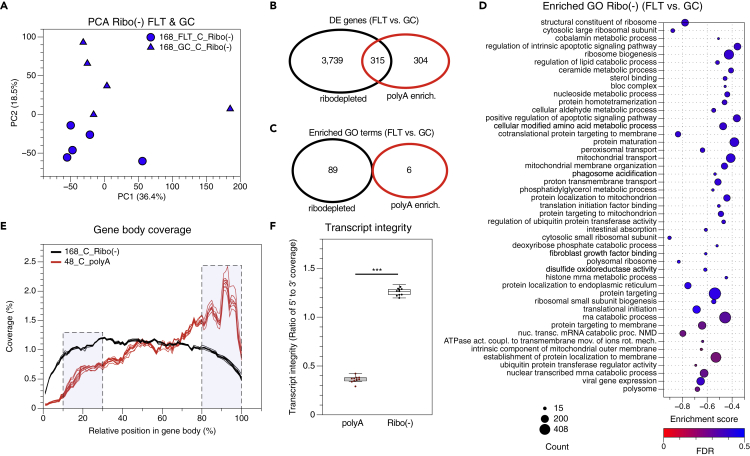
Evaluation of Gene Expression and Transcript Integrity in RR-1 NASA Carcass-dissected FLT and GC Samples Prepared via polyA Selection and Ribodepletion Methods(A) Principal component analysis of global gene expression in RR-1 NASA spaceflight (FLT) and ground control (GC) liver samples dissected from frozen carcasses (C) and prepared via ribodepletion (Ribo(−)). Percent variance for each principal component (PC) are shown.(B) Venn diagram of differentially expressed (DE) genes between spaceflight (FLT) and ground control (GC) samples prepared with ribodepletion (black) or polyA selection (red) methods (adj. p value < 0.05).(C) Venn diagram of the number of similar and unique enriched gene ontology (GO) terms (spaceflight (FLT) versus ground control (GC)) identified in ribodepleted (black) and polyA selected (red) prepared samples (NOM p < 0.01, FDR <0.5, phenotype permutation).(D) Enriched GO terms between the spaceflight (FLT) and ground control (GC) carcass samples prepared with ribodepletion identified by Gene Set Enrichment Analysis (phenotype permutation). The more positive or negative the enrichment scores, the higher the expression in spaceflight or ground control samples, respectively. Dot size indicates number of genes within GO term. Dot color indicates false discovery rate (FDR). GO terms displayed met the thresholds of FDR <0.5, NOM p < 0.01, 1.6 < NES < −1.6.(E) Gene body coverage of ribodepleted (Ribo(−)) and polyA selected (polyA) spaceflight and ground control carcass (C) samples.(F) The percent coverage of the 5′- and 3′-shaded regions in panel E were used to calculate the transcript integrity ratio for each sample (∗∗∗ = p < 0.001, Mann–Whitney U test). Data are from GLDS-48 and -168.